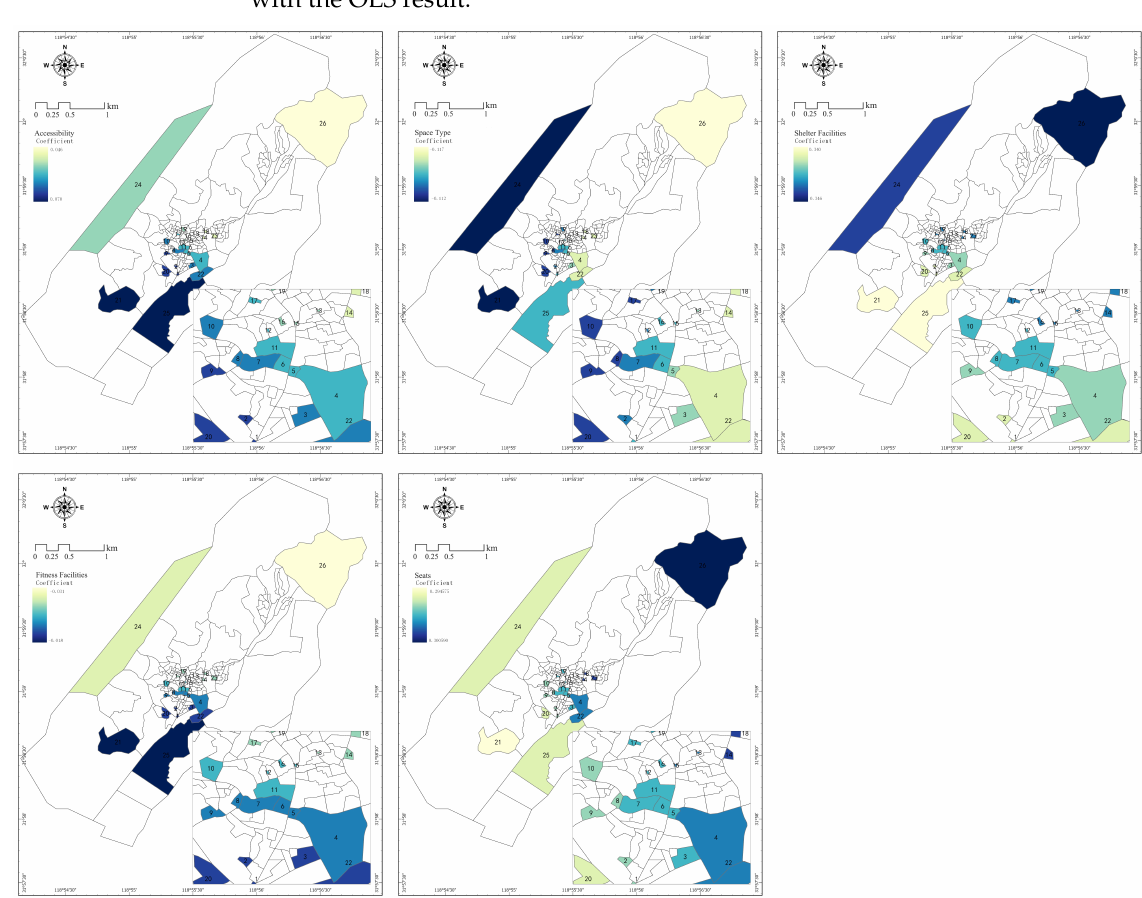
Figure 7. . Figure 7. Spatial Patterns of Regression Coefficients between Resident Vitality and the Factors of